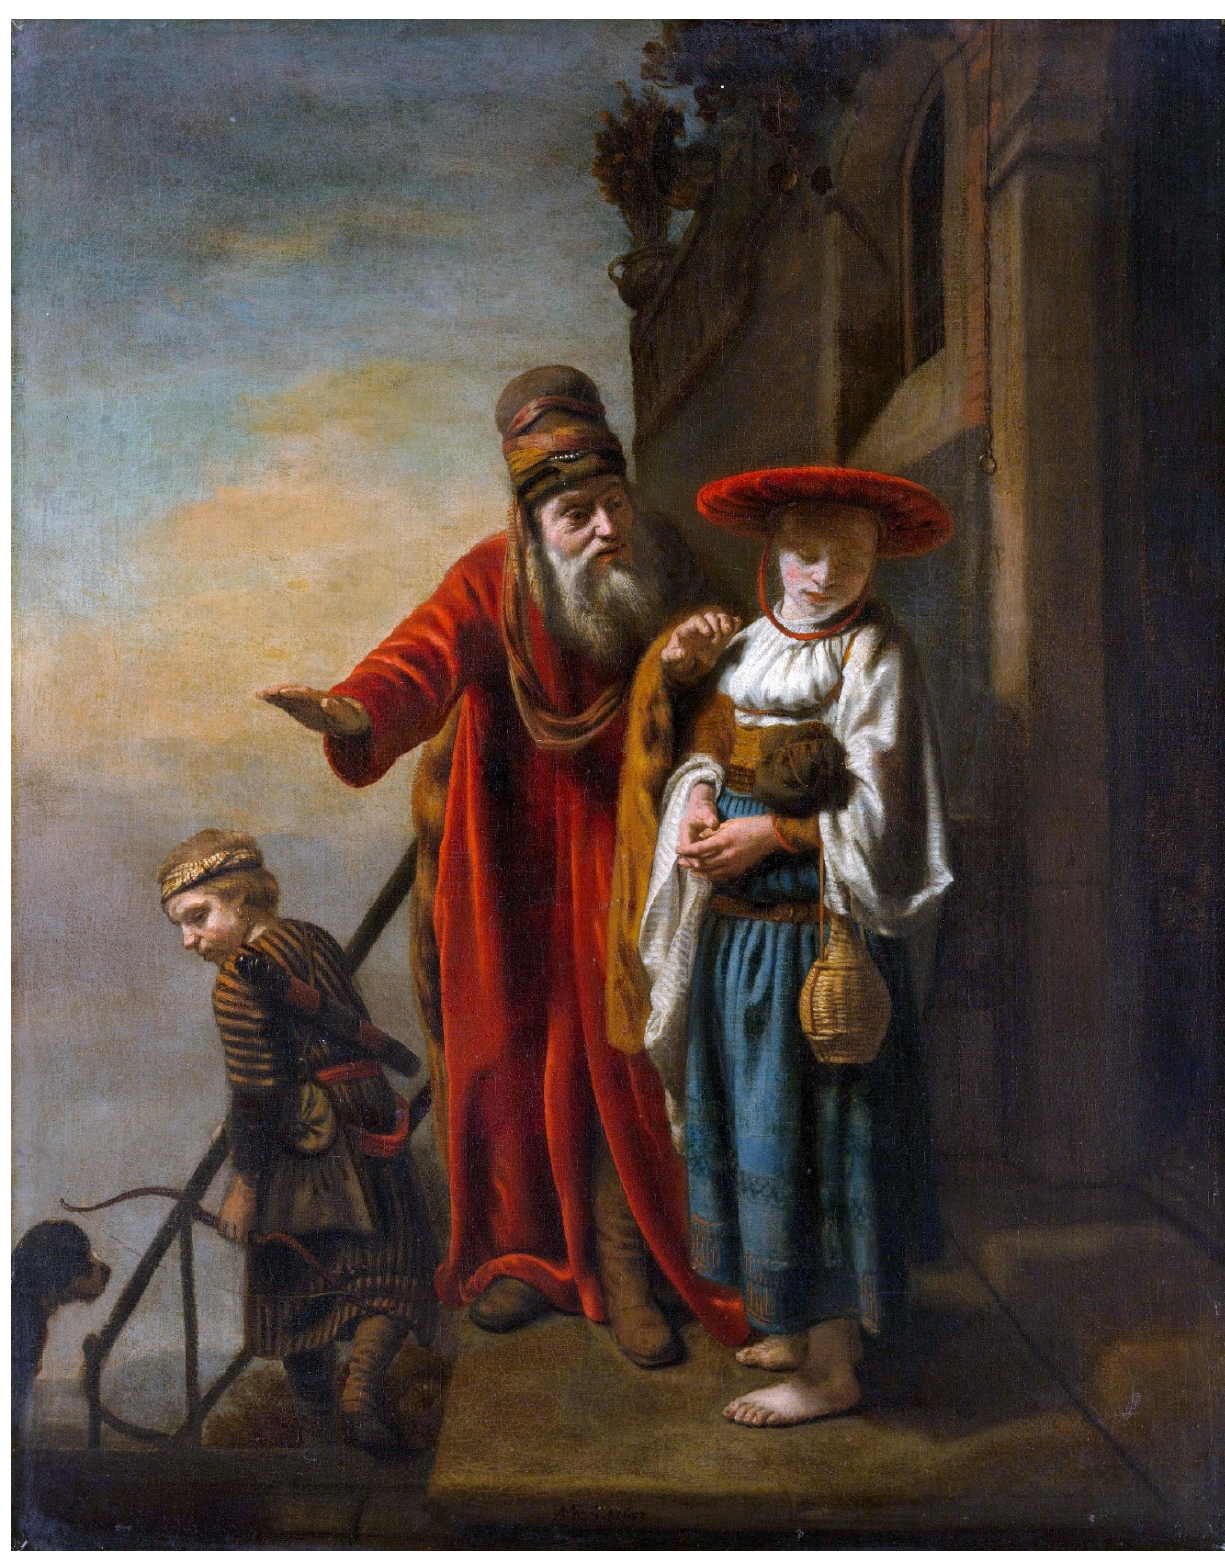
Figure 15. Nicolas Maes, 1653. New York, The Metropolitan Museum of Art.